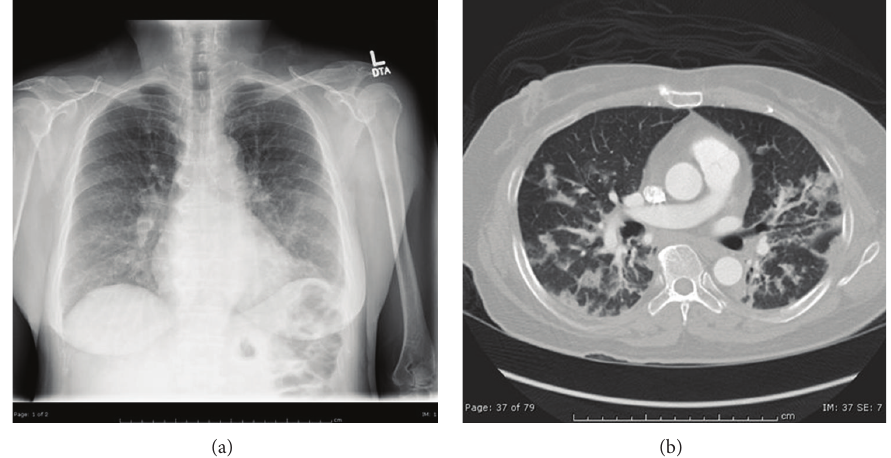
Figure 6: Lung imaging on admission. (a) Chest radiograph showing prominent interstitial lung markings. (b) CT pulmonary angiogram showing multifocal opacities and